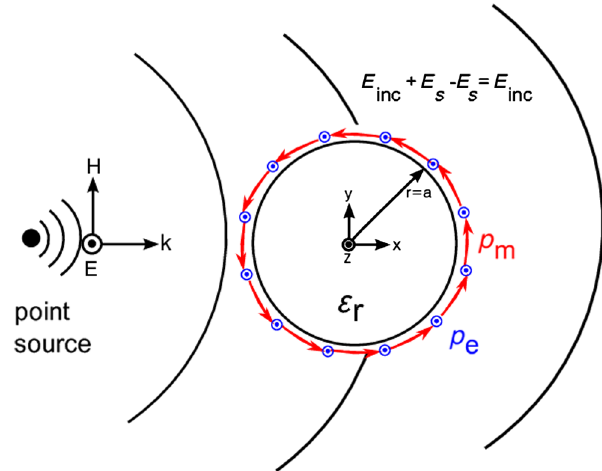
FIG. 1. The geometry of the scattering problem discussed. A point source with the illustrated polarization illuminates a cir- cular PEC scatterer. To cloak the PEC scatterer, it is surrounded by magnetic dipoles, with a specific weight on each dipole determined by the scattered